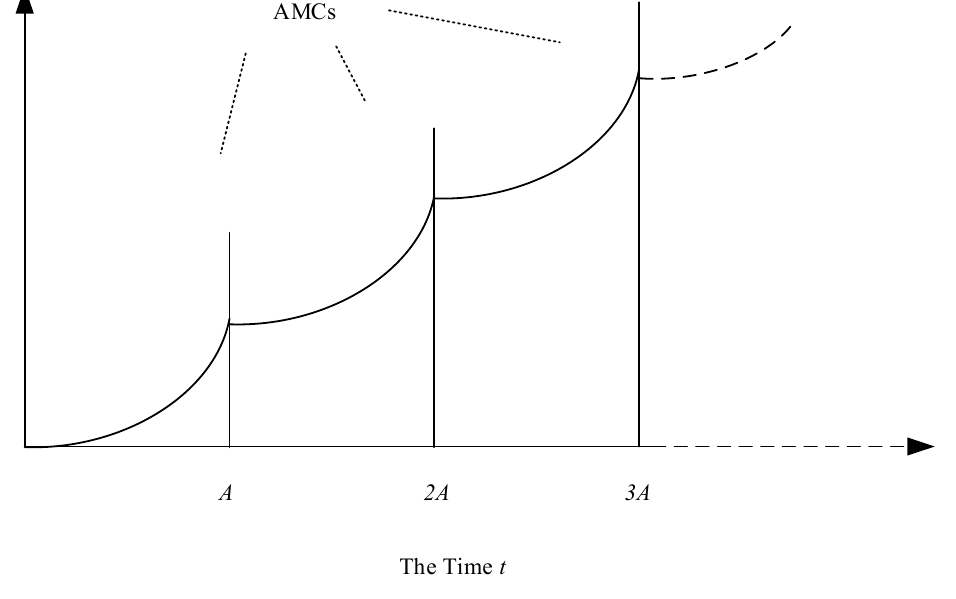
Figure 1. The mosquito control strategy.